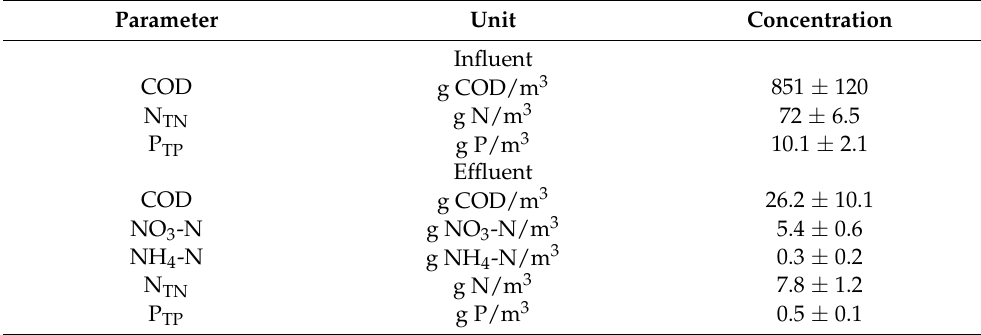
Table 1. Average values of the basic pollution indicators in the influent and effluent from Poznan WWTP during the experimental